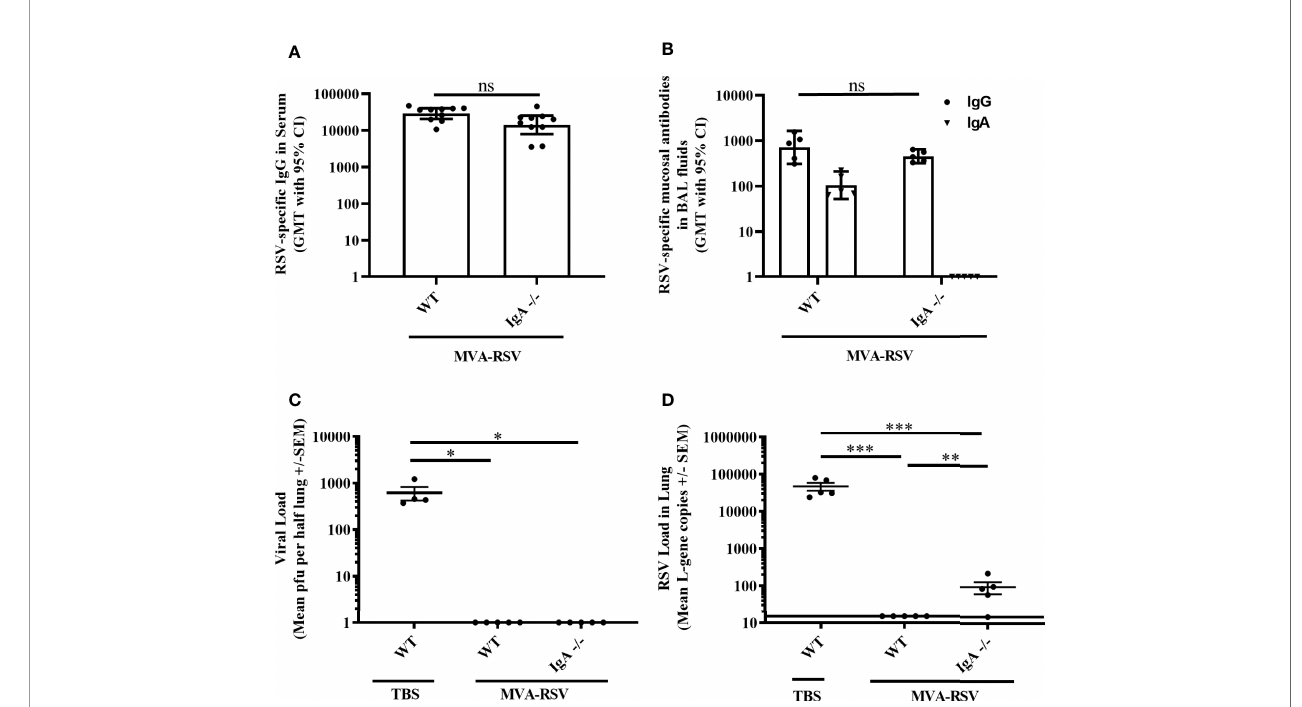
FIGURE 4 | Role of IgA for RSV protection. C57BL/6 WT ( n = 5 to 10) or IgA-de fi cient (IgA-/-, n = 5 to 10) mice were vaccinated (IN) twice 3 weeks apart with 1 × 10 8 TCID 50 MVA-RSV. C57BL/6 WT mice treated with TBS served as controls. (A) RSV-speci fi c IgG in serum was measured on Day 34 (13 days post last vaccination) by ELISA. Geometric mean titers (GMT) with 95% con fi dence interval (CI) are shown. Titers were similar between vaccinated WT mice and IgA -/- mice ( p = 0.054, Mann – Whitney U -test). (B) RSV-speci fi c mucosal IgA and IgG in BAL fl uids were measured on Day 39 (4 days post challenge) by ELISA. GMT with 95% CI is shown. Mucosal IgG titers were comparable between vaccinated WT mice and IgA -/- mice ( p = 0.4206, Mann – Whitney U -test). Mucosal IgA was